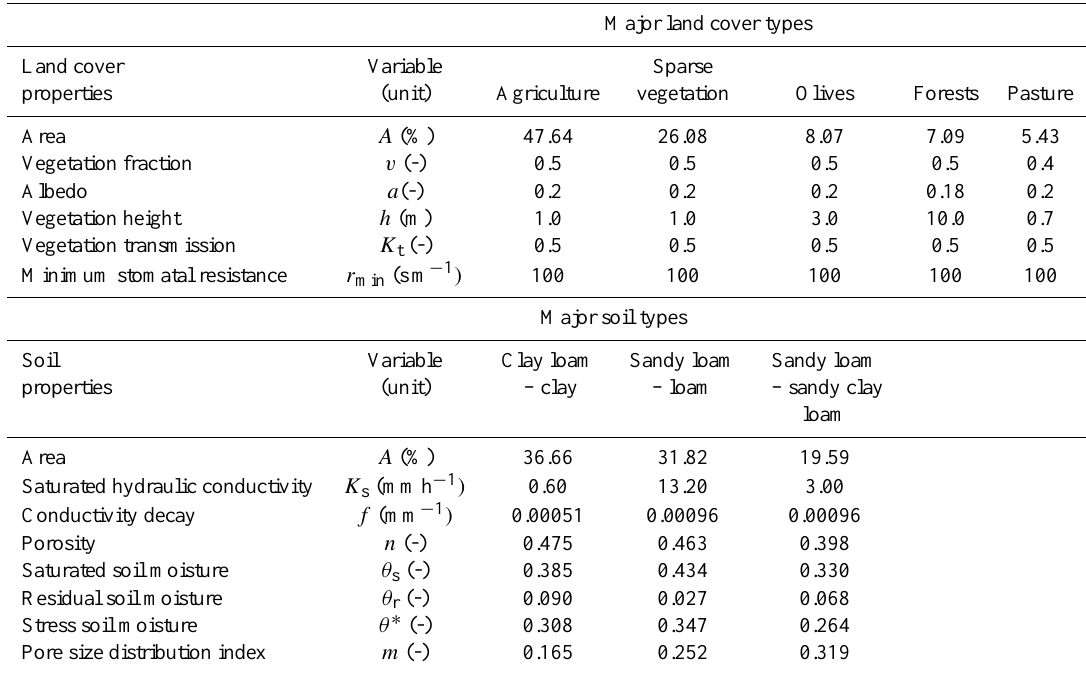
Table 8. Parameters of the tRIBS model for the major soil and land cover classes in the RMB.